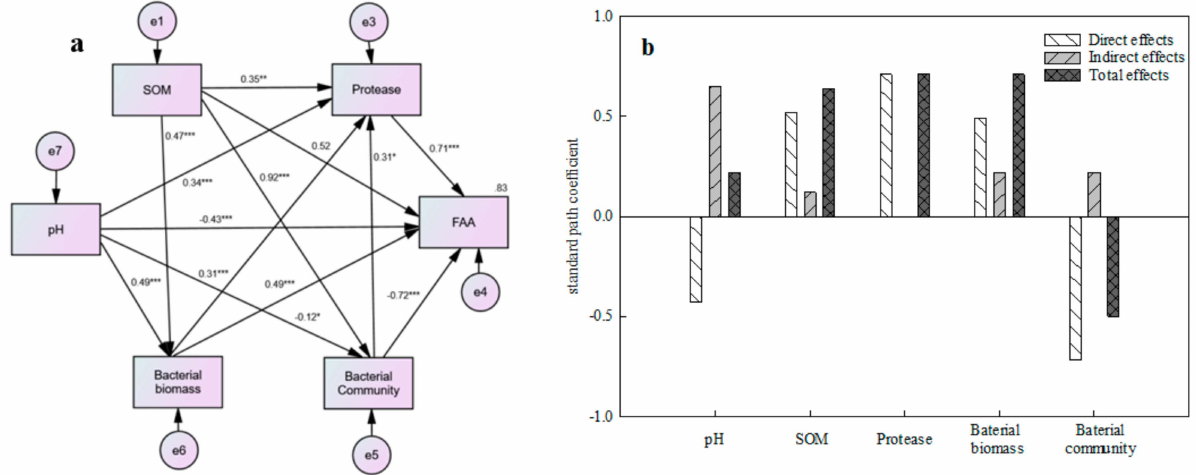
Figure 8. Structural equation modeling ( a ) and standard path coefficient ( b ) of impact factors on soil FAAs during the rice growth stage. Note: The values next to the arrow are standard path coefficients (also known as regression coefficients), *, **, *** Significant at p < 0.05, p < 0.01, p < 0.001, respectively, e1–e6: errors 1–6.